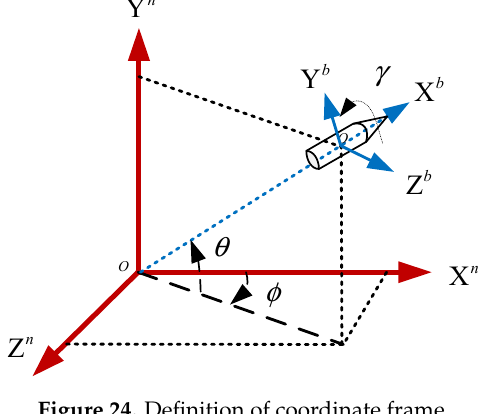
Figure 22. Magnetometer outputs of Z-axis. Figure 23. Outputs error versus time. Figure 23. Outputs error versus time.